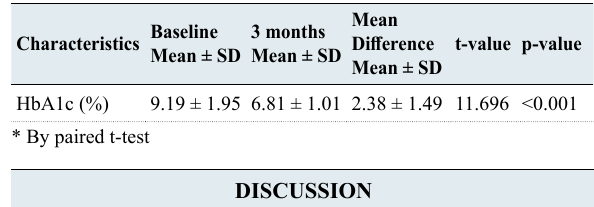
Table 3: Serum test results